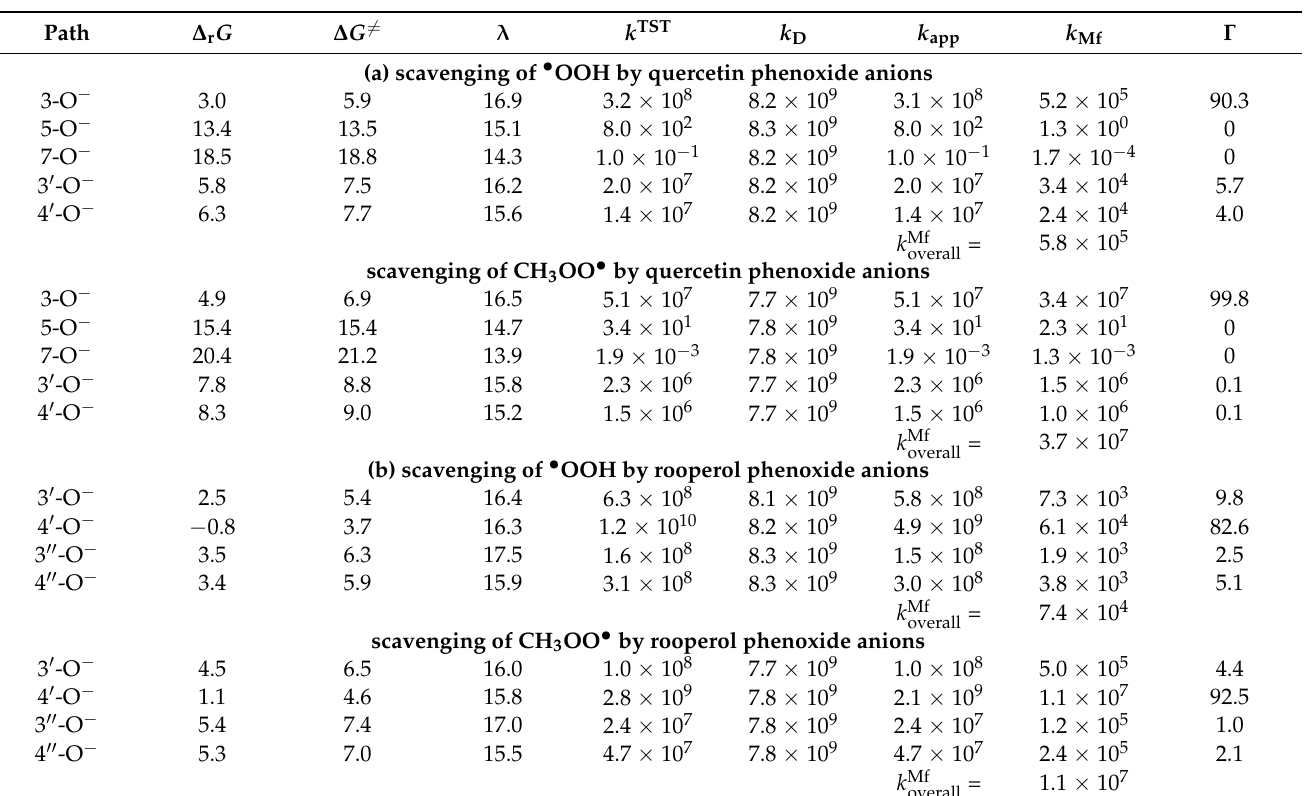
Table 3. Reaction Gibbs free energy ( ∆ r G , kcal/mol), Gibbs free energy of activation ( ∆ G (cid:54) = , kcal/mol), reorganization energy ( λ , kcal/mol), TST rate constant ( k TST , M − 1 s − 1 ) diffusion rate constant ( k D